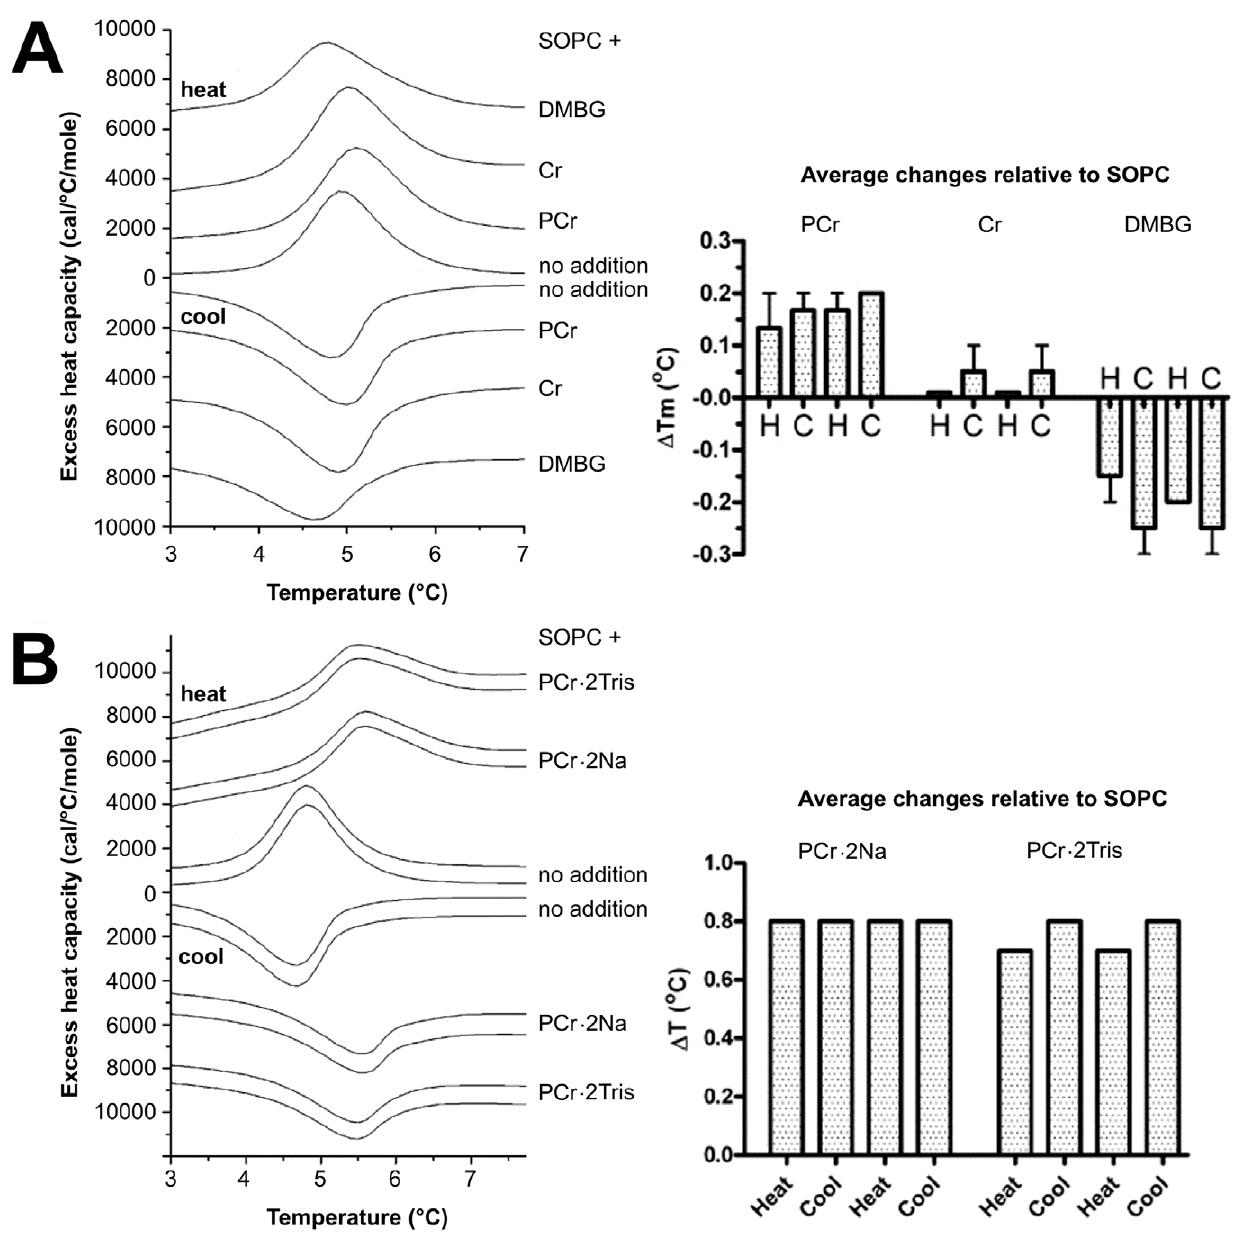
Figure 4. Effect of phosphocreatine, creatine and dimethylbiguanidium chloride on the lipid phase transition as determined by differential scanning calorimetry. Thermograms (left) and quantified phase transition temperature shifts (right) obtained by heating or cooling of a suspension of SOPC in PIPES buffer (20 mM PIPES pH 7.4, 140 mM NaCl, 1 mM EDTA) alone (middle scans in A or B, labeled ( 2 ). (A) one heating and one cooling scan shown with added 100 mM PCr, Cr or dimethylbiguanidium chloride (DMBG), or (B) two cycles of heating and cooling shown for each sample. 500 mM PCr Na-salt or Tris-salt (omitting NaCl). Thermograms (left) are from representative runs, histograms (right) represent averaged data from 3 independent experiments (H = heating; C =